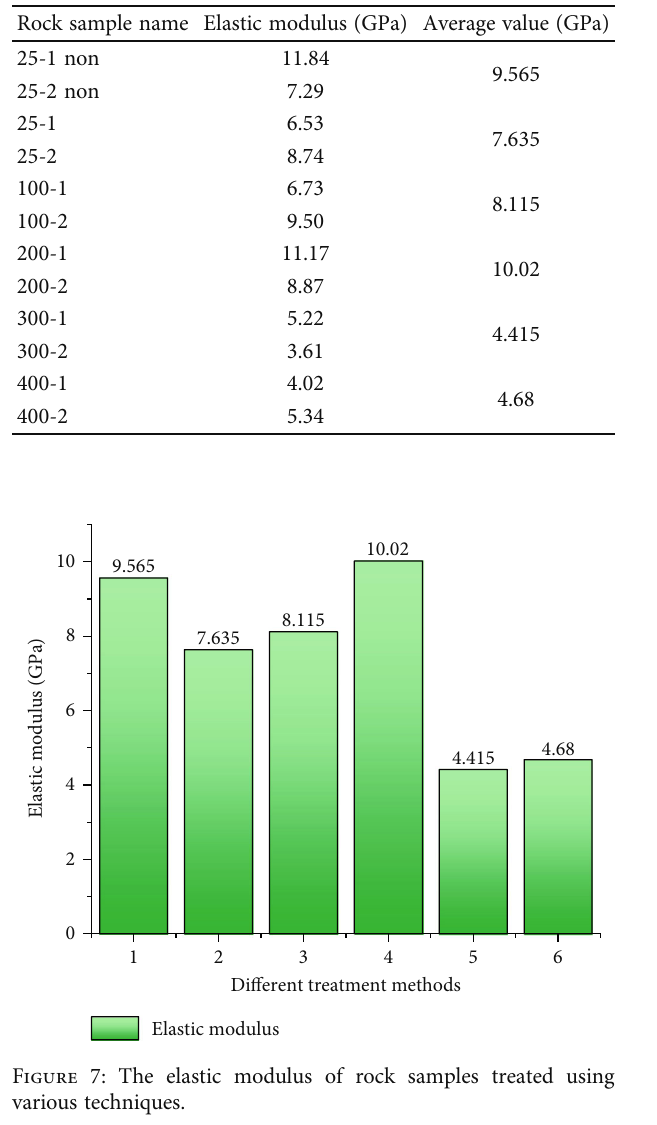
Table 4: Poisson ’ s ratio of di ff erent samples.